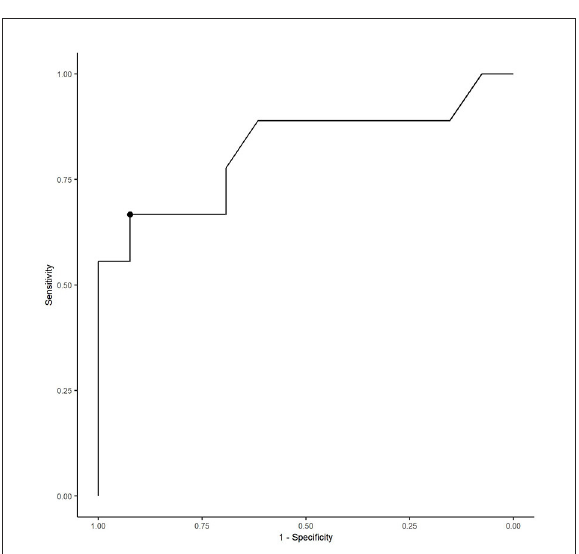
FIGURE5 Receiver operating characteristic curve for LUS score to predict presence or absence of lower respiratory tract disease. The optimal cutoff score of 37 gave a sensitivity of 67% and specificity of